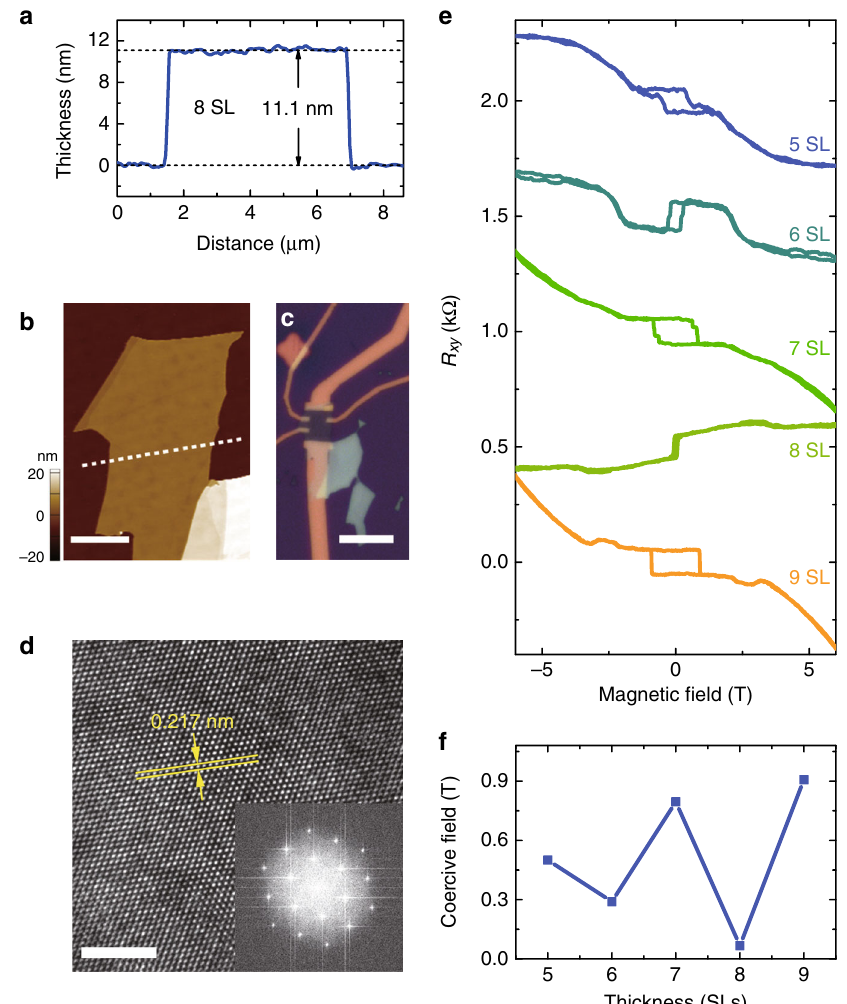
Fig. 4 Device fabrication and the thickness-dependent AHE signals. a , b Atomic force microscopy line scan pro fi le and the corresponding photograph of a typical exfoliated Mn(Sb 0.1 Bi 0.9 ) 2 Te 4 fi lm with 8 SL. Scale bar in b : 3 μ m. c An optical photograph of the typical fabricated mesoscopic device. Scale bar: 10 μ m. d An HR-TEM image and the FFT pattern (inset) of a typical exfoliated thin fi lm of Mn(Sb 0.1 Bi 0.9 ) 2 Te 4 . Scale bar: 3 nm. e Hall resistance measured at 2 K in the Mn(Sb 0.1 Bi 0.9 ) 2 Te 4 thin devices with different thicknesses. f The thickness-dependent coercive fi elds extracted from